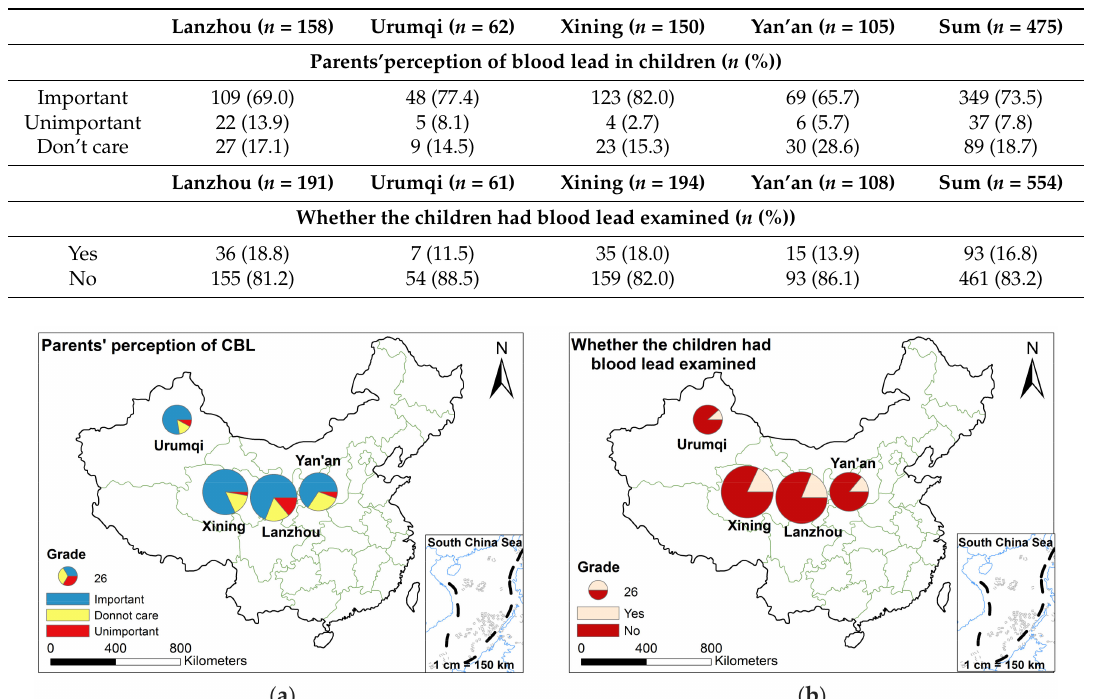
Table 9. Parents’ perception of blood lead in children and blood lead test in four cities.